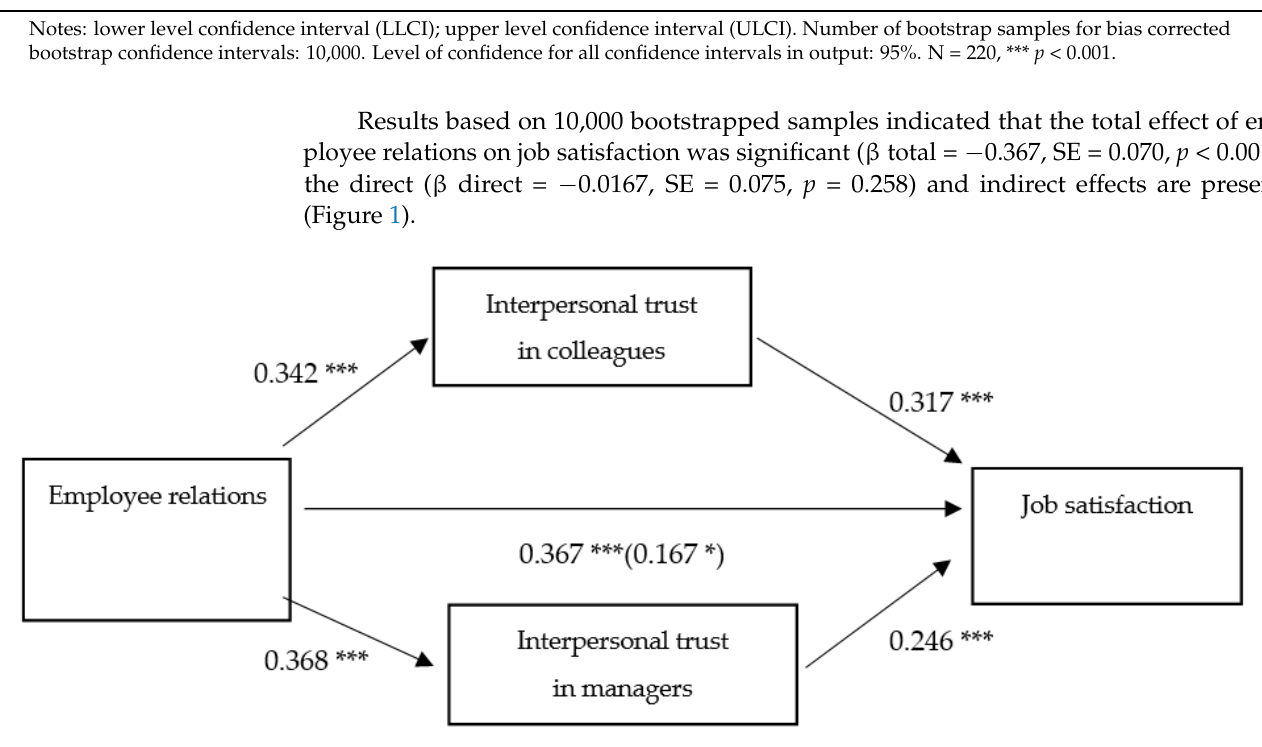
Figure 1. Parallel mediation model ( n = 220). Indirect effects of employee relations on job satisfaction through interpersonal trust in colleagues and interpersonal trust in managers. Standardized effects estimates are presented. The effects on the direct path from employee relations to Job satisfaction depict the direct effect and the (total effect). * p = 0.028, *** p < 0.001.